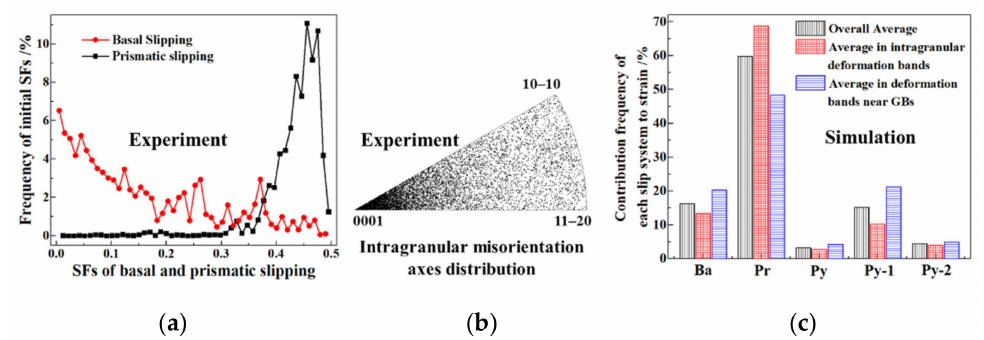
Figure 8. Analysis of activated slip systems of TA15 sample during hot tension (750 ◦ C–0.01 s − 1 –true strain 0.1). ( a ) Initial distribution of basal and prismatic SFs; ( b ) intragranular misorientation axes distribution after deformation in experiment; ( c ) contribution frequency of each slip system to strain in